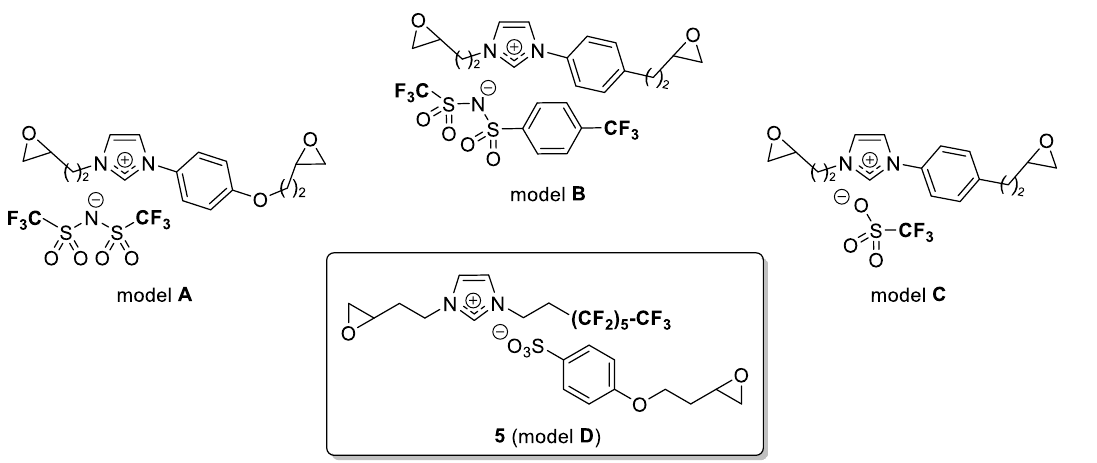
Figure 1. Example of diepoxy perfluorinated salts in relation to sulfonate 5 . Model A: Unmodified commercial triflimide; Model B: Homemade perfluorinated sulfonimide; Model C: Unmodified commercial trifluoromethylsulfonate; Model D: Homemade functionalized sulfonate with perfluorinated imidazolium.